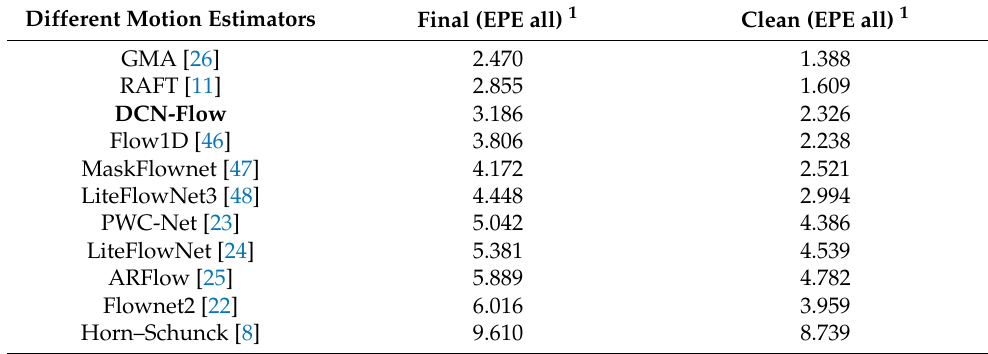
Table 2. Evaluation results of different motion estimators on the MPI-Sintel test